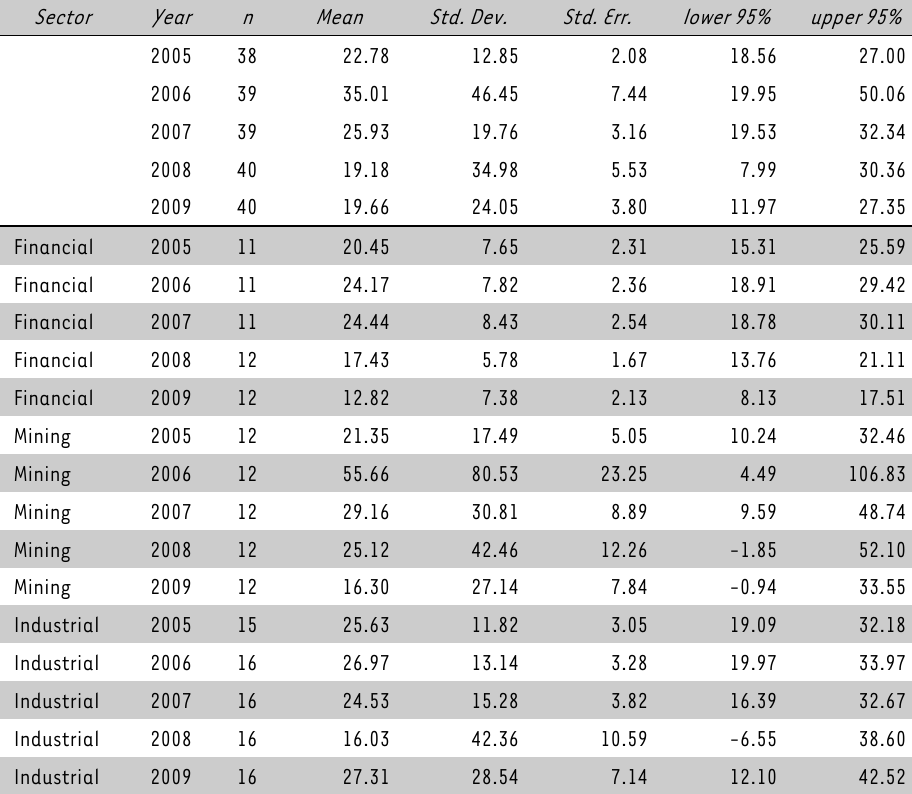
TABLE 7: Descriptive statistics for ROE All figures except for n are given as a